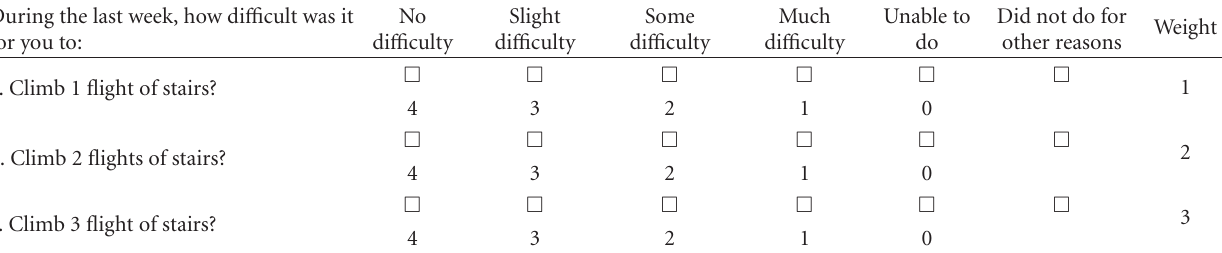
Table 8: Stair subscale of the